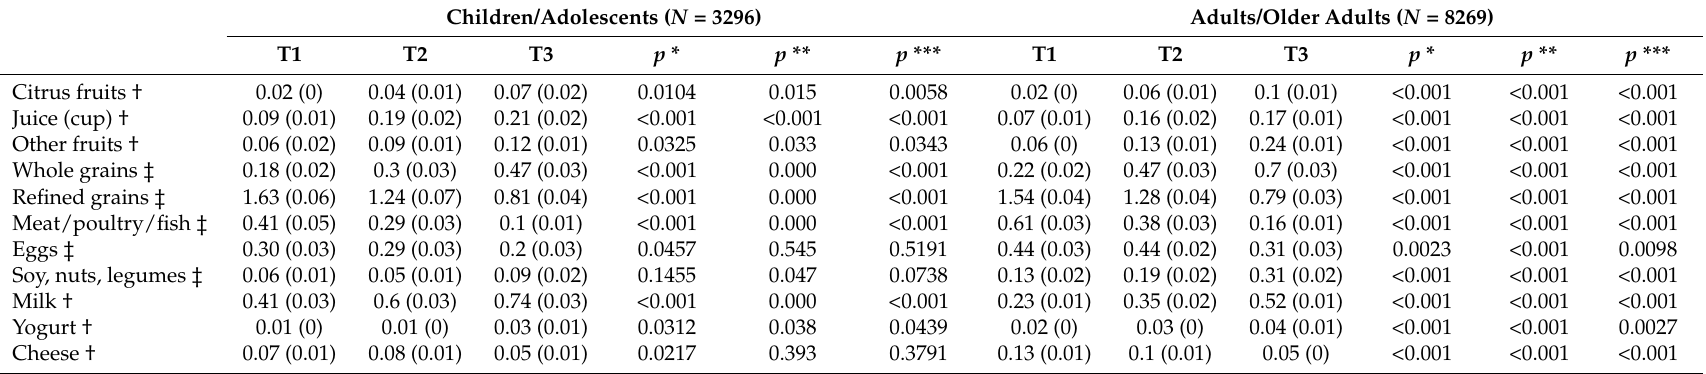
Table 3. Amounts of selected food groups consumed at breakfast across tertiles of NRF 9.3 score by age group. Data for breakfast consumers